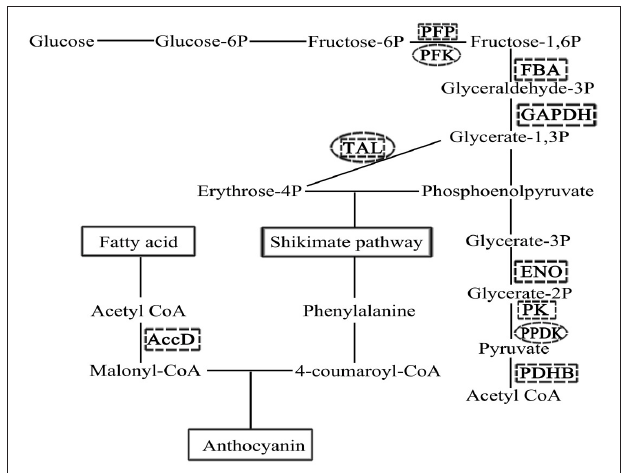
FIGURE 7 | Schematic representation of the supply of precursors for the anthocyanin biosynthetic pathway. The formation of two reaction substrates in anthocyanin biosynthesis, malonyl-CoA and 4-coumaroyl-CoA, were linked to glycolysis, pentose phosphate pathway, shikimate pathway, and fatty acid metabolism. Enzymes identified by proteomics (marked with a dotted square) or SSH (marked with a dotted circle) were shown in bold uppercase letters (AccD, acetyl-CoA carboxyltransferase, β subunit; PFP, pyrophosphate: fructose 6-phosphate 1- phosphotransferase; PFK, 6-phosphofructokinase; FBA, fructose-bisphosphate aldolase; GAPDH, glyceraldehyde-3-phosphate dehydrogenase; ENO, enolase; PK: pyruvate kinase; PPDK: pyruvate phosphate dikinase; PDHB, pyruvate dehydrogenase E1 subunit β ; TAL: